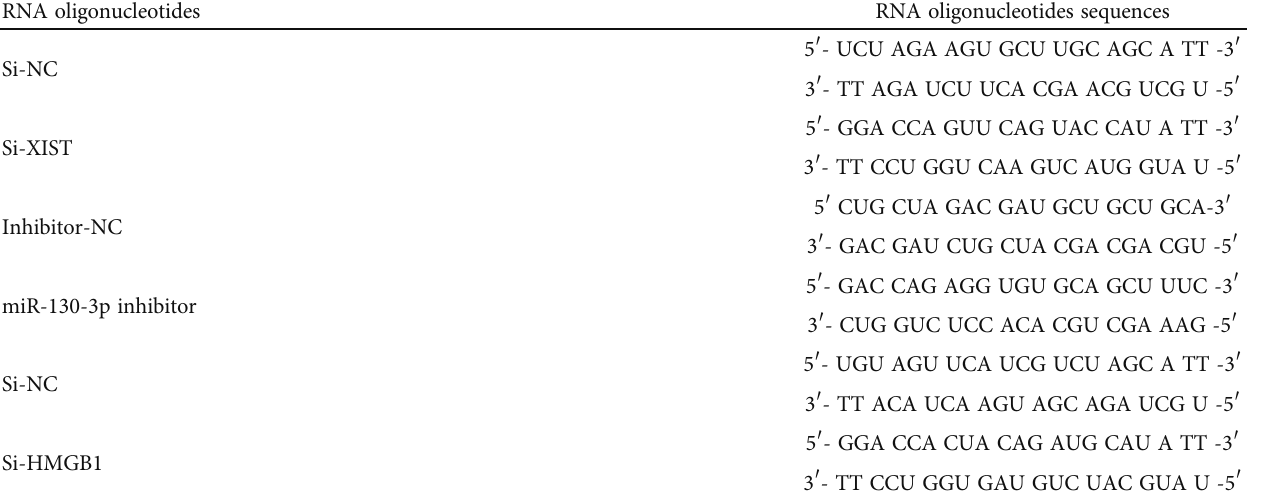
Table 1: RNA oligonucleotides used for cell